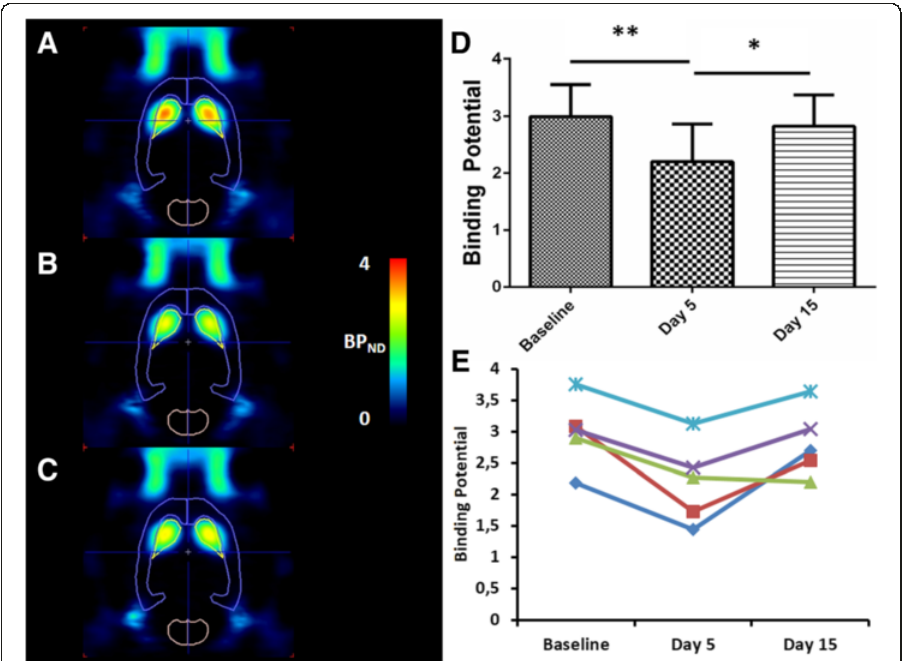
Fig. 5 [ 18 F]JNJ42259152 BP ND values after 5 days treatment with SCH23390. Left : Transversal images of PDE10A binding in the brain. Images are overlaid on a VOI map and presented as averaged, parametric BP ND images (Logan Reference) at baseline conditions ( a ), at day 5 ( b ) and day 15 ( c ) of the experiment. Right : Averaged ( d ) and individual ( e ) BP ND values in striatum of SCH23390 treated rats at baseline conditions, after 5 days of amphetamine treatment (day 5) and after 10 days of washout (day 15). Each line represents a repeated measurement in a single rat at different stages of treatment. Wilcoxon matched pair test; * p <0.05, ** p